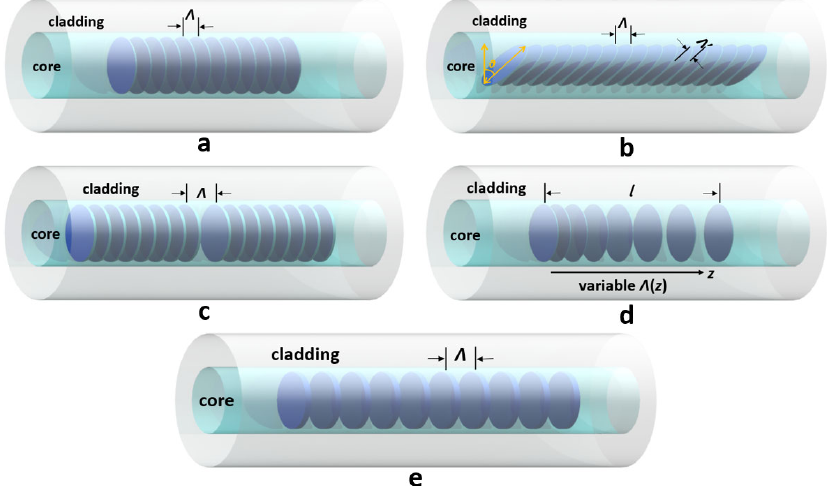
Figure 10. The structural diagrams of standard FBG ( a ), TFBG ( b ), PSFBG ( c ), CFBG ( d ) and LPFG ( e ). Light guided along the fiber core is scattered by each grating plane. If the Bragg con ‐ dition is unsatisfied, the reflected light from each of the subsequent planes becomes pro ‐ gressively out of phase and finally cancels out. Oppositely, if the Bragg condition is satis ‐ fied, the contributions of reflected light from each grating plane are added up in a con ‐ structive manner in the backward direction to form a back ‐ reflected peak with a center wavelength defined by the grating parameters [69]. Such a grating works as a special mir ‐ ror that reflects light only in a narrow band around the Bragg wavelength 𝜆 (cid:3003)(cid:3045)(cid:3028)(cid:3034)(cid:3034) , while transmitting other wavelengths. The Bragg wavelength is expressed by: